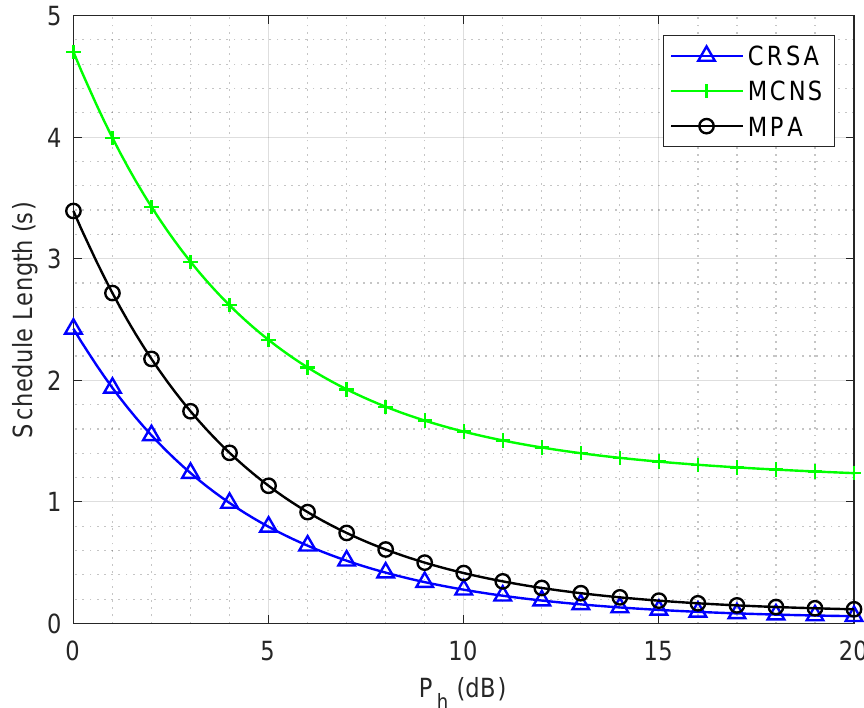
Figure 2. Schedule length of the algorithms for different HAP transmit powers in a network of 10 cells and 50